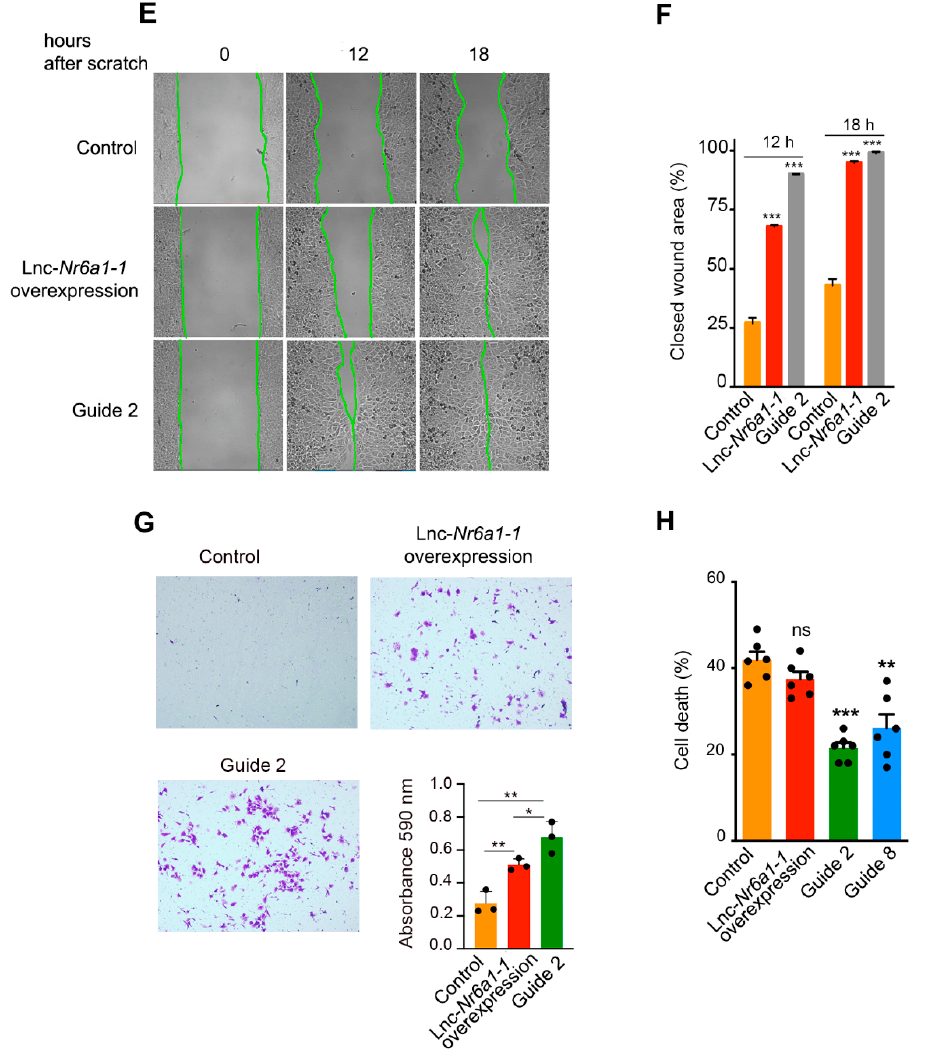
Figure 6. Over-expression of Lnc-Nr6a1 . ( A ) Diagram of CRISPR SAM-CRISPR/Cas9 activation system. Nuclease-dead Cas9 (dCas9), fused to the transcriptional activator VP64, complexes with the CRISPR guide RNA. MS2 bacteriophage coat protein is fused to the p65 subunit of NF-kappaB and the activation domain of human heat-shock factor 1 (HSF1). MS2 coactivator proteins bind to MS2 RNA aptamer in the gRNA and with VP64 synergistically activate gene expression. ( B ) Expression levels of lnc- Nr6a1 isoforms and miR-181a2-3p in cells lines with different sgRNAs (within the region from − 285 to +105bp, distance to TSS). Hprt and miR-425-5p genes were used to normalize expression of lnc- Nr6a1 isoforms and mR-181a2/b2, respectively. ( C ) Representative image from immunofluorescence staining of changes in the expression of marker proteins. Cells were stained with antibodies against the epithelial marker E-cadherin, mesenchymal marker N-cadherin and 4,6-diamidino-2-phenylindole to visualize nuclei. Scale bar, 25 µM. ( D ) Representative immunoblotting of E-cadherin and N-cadherin in control, lnc -Nr6a1-1 -upregulated and Lnc-Nr6a1 -upregulated cells (guide 2 and guide 8). Quantification of E-cadherin and N-cadherin in three independent experiments is shown in panel 6D (down). Error bars represent S.D. *** p < 0.001, ** p < 0.01, ns, not significant by two-tailed Student’s t -test. Protein-loading normalization was performed by measuring total protein directly on the membrane using the criterion stain-free gel imaging system. ( E ) The migratory capacity of the control lnc- Nr6a1-1 - and Lnc-Nr6a1 -upregulated cells were tested in wounding-healing assays. Cells were imaged at 10 min intervals for 24 h. The frames of the movie at 12 and 18 h are shown. ( F ) The frames at 12 and 18 h were used to estimate the percentage of surface covered by the cells. Experiments were performed in triplicate samples. Values represent the percentage of wound closure. Error bars represent S.D. p -values for comparisons are indicated. *** p <